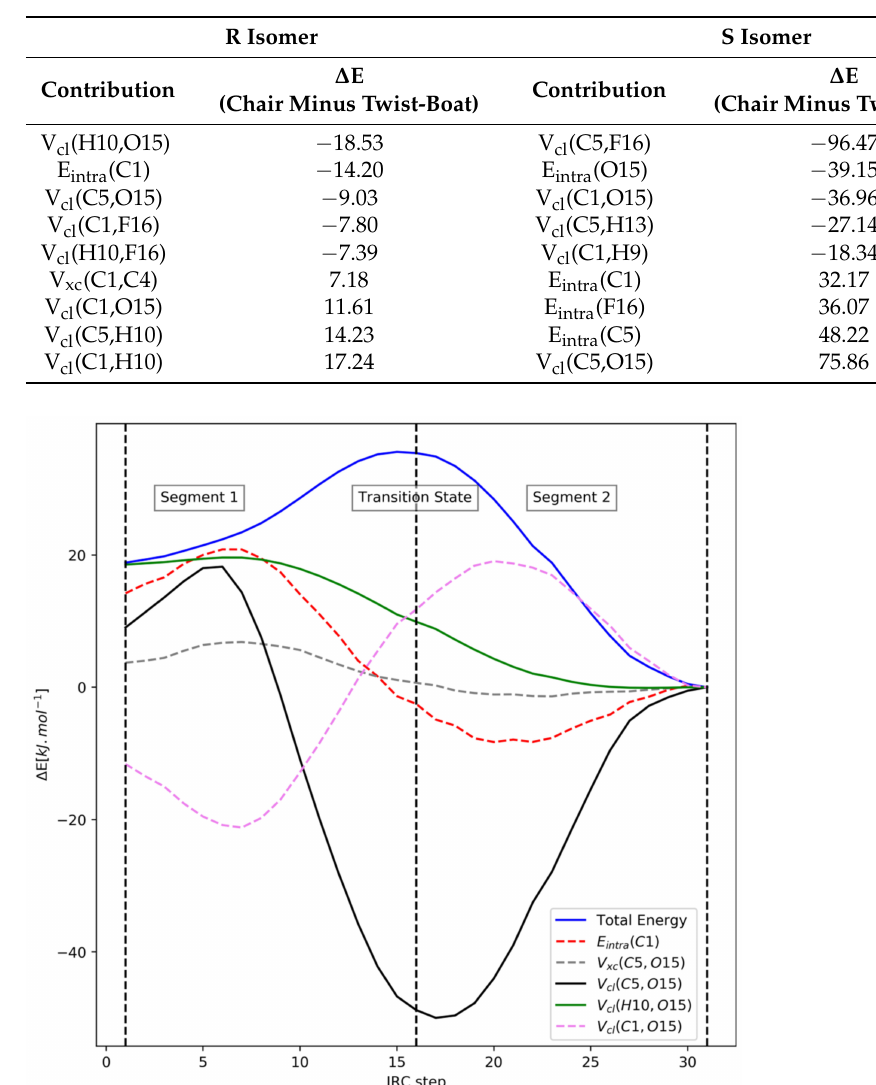
Figure 8. Visualization of the energetic terms in the R